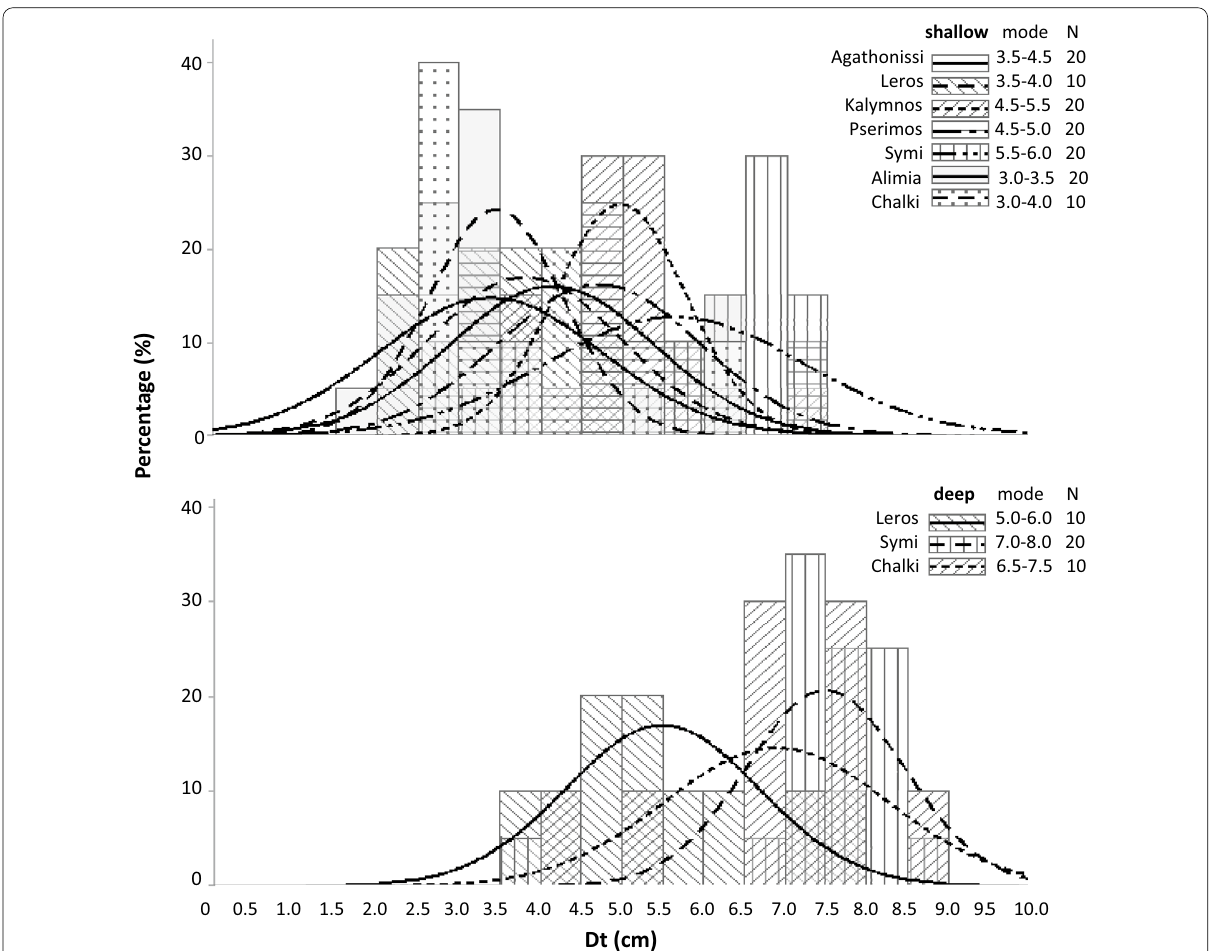
Fig. 6 Size (Dt test diameter)—frequency distribution of the studied Diadema setosum population per island, in the shallower (top graph) and = deeper (lower graph) depth distributional zone of the species